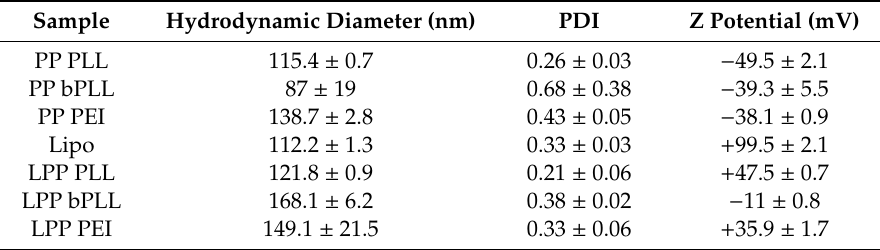
Table 1. Characterization of the prepared particles by DLS and Z